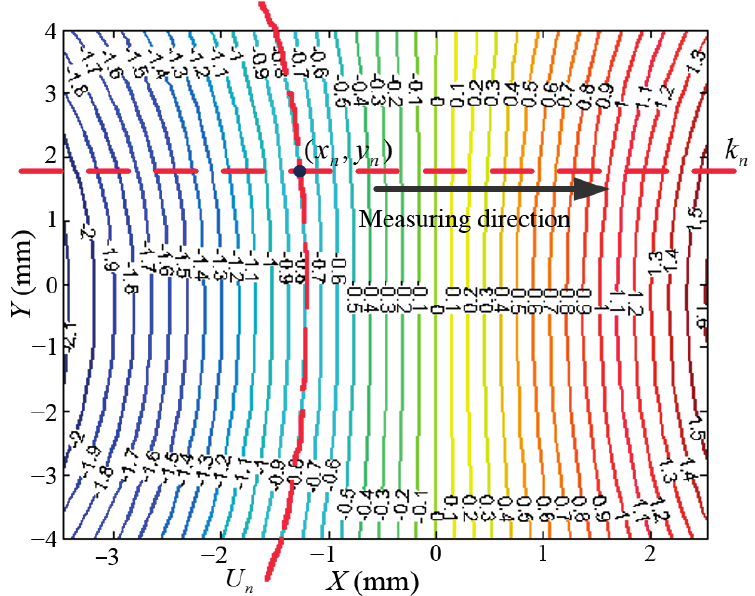
Figure 14. Calibration of the initial position of X Hall sensor.